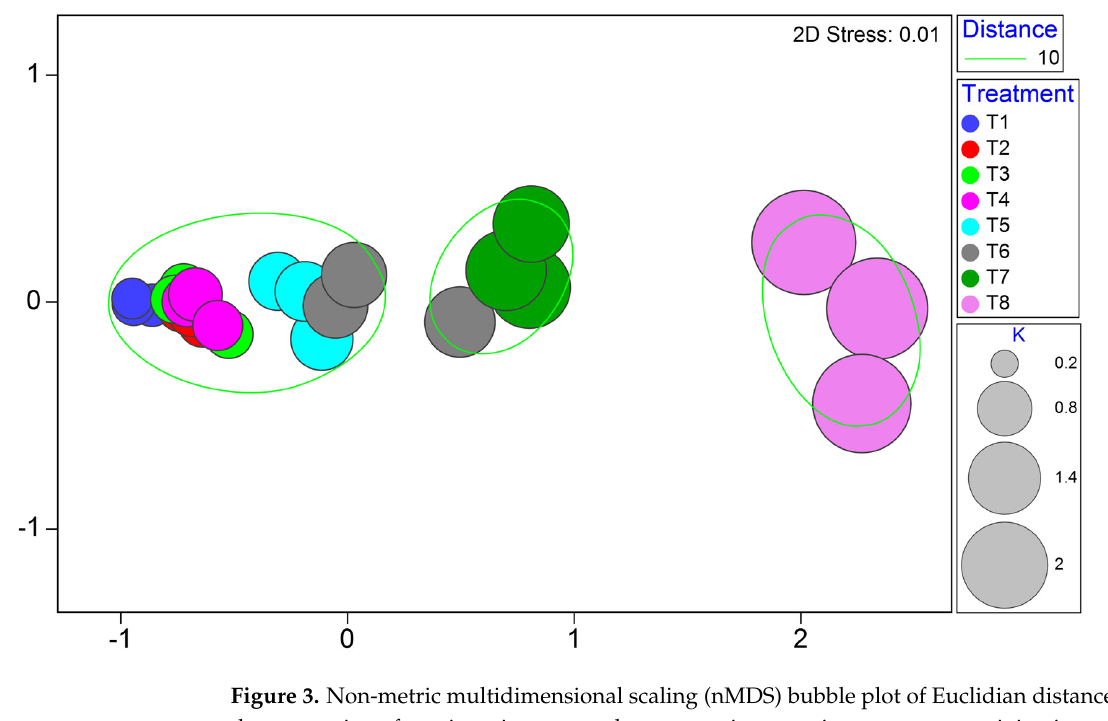
Figure 3. Non-metric multidimensional scaling (nMDS) bubble plot of Euclidian distances between the proportion of nutrients in tomato plant vegetative parts in treatments receiving increasing UWP supplement rates (T1 = 0.3%; T2 = 0.5%; T3 = 0.8%; T4 = 1%; T5 = 2%; T6 = 3%; T7 = 5%), and Hoagland’s solution (T8). Samples treatments grouping are the results of an overlayed cluster analysis by group average of resemblance distance. Bubble size indicates K content (g 100 g − 1 ).